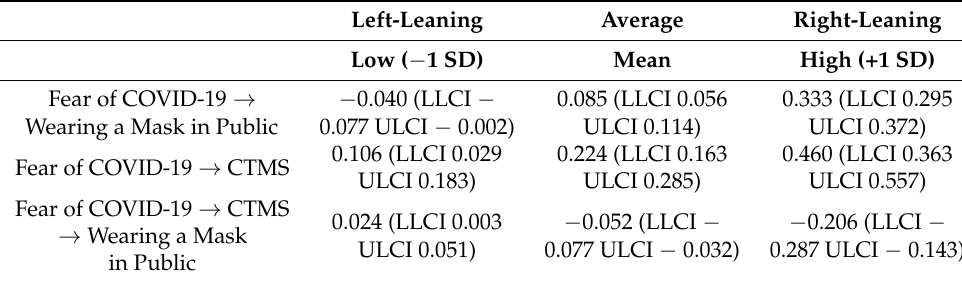
Table 7. Study 4 conditional direct and indirect effects with callousness as